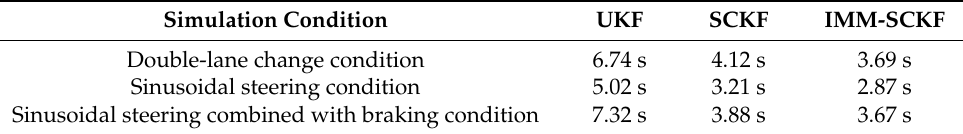
Table 3. Comparison of the actual computing time consumed by various algorithms. Simulation